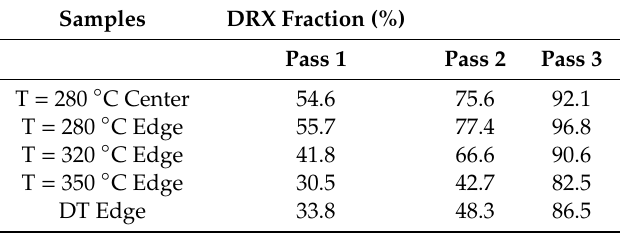
Table 3. The area fraction of dynamic recrystallization (DRX)ed grains of di ff erent